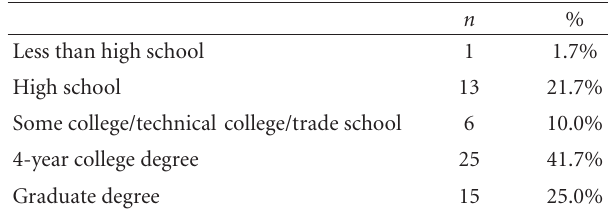
Table 1: Highest education of North Carolina forest manager, logger, and forest landowner respondents ( n =